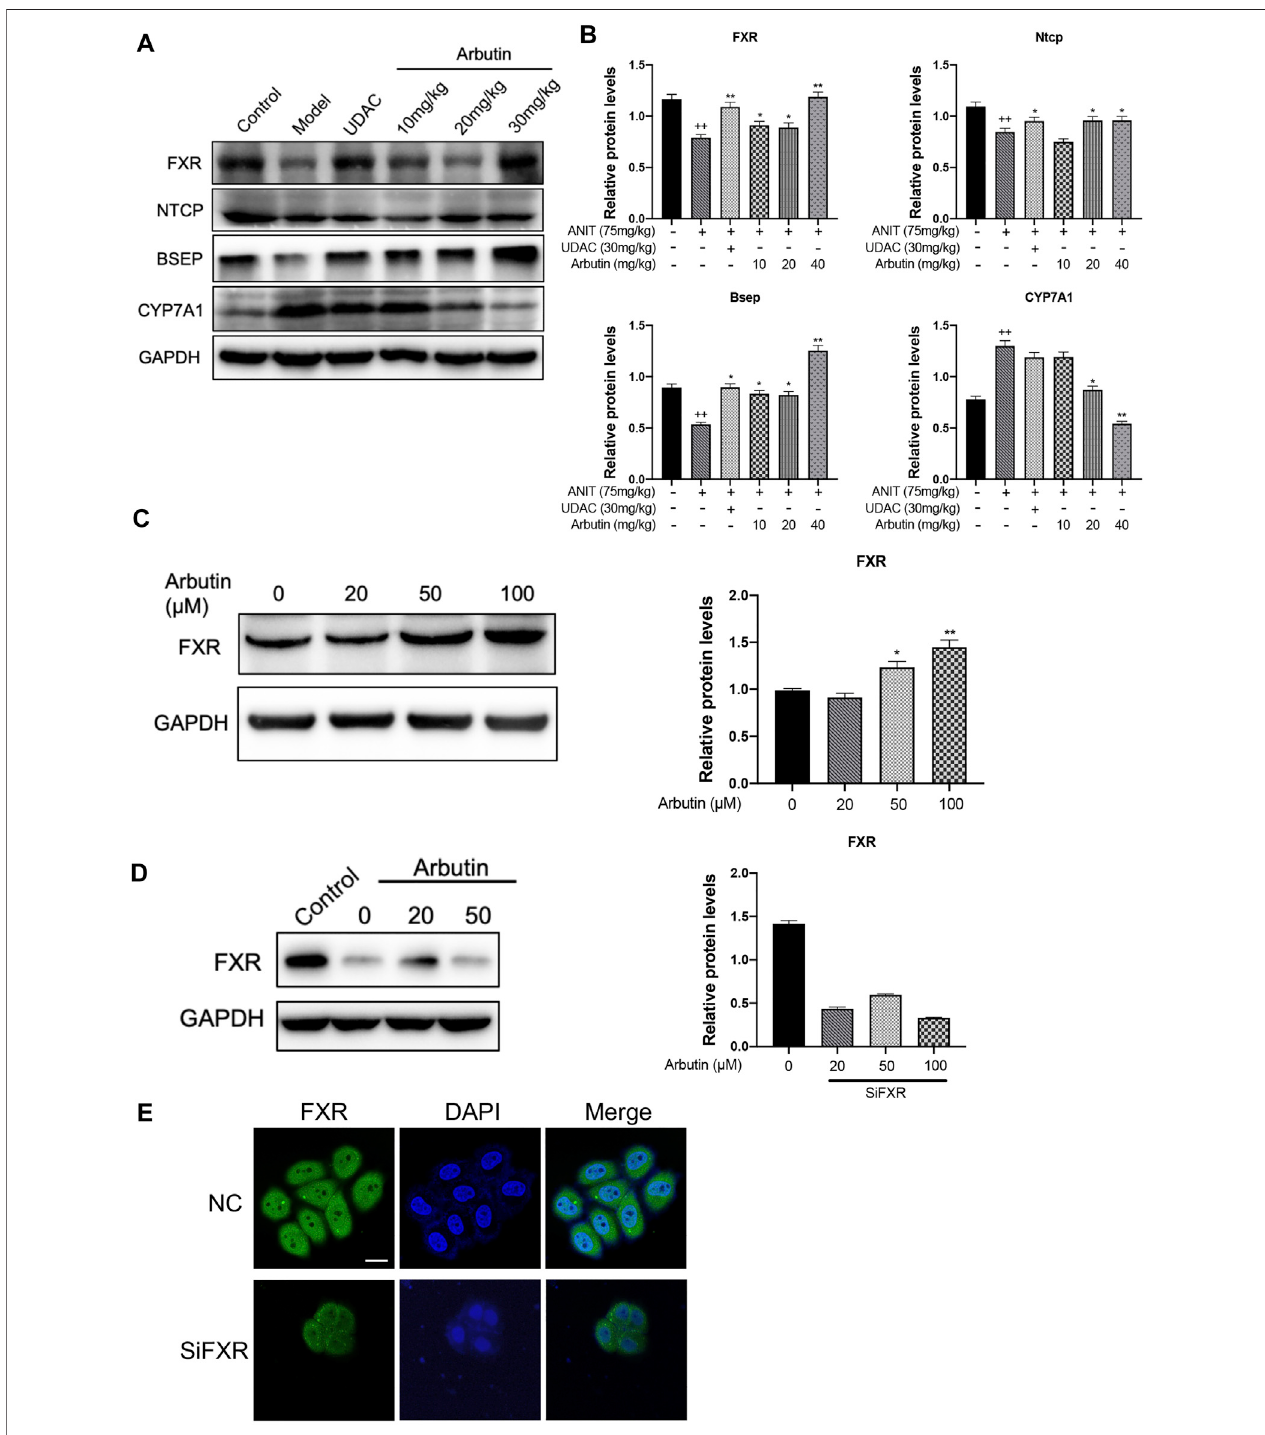
FIGURE 5 | Hepatoprotective effects of arbutin on the FXR signaling pathway in ANIT-induced cholestatic liver disease. (A) WB analysis was applied to shown proteinlevelsofFXR,Ntcp,Bsep,andCYP7A1withtreatment indicated. (B) Theanalysisoftheindicatedproteins. (C) WBanalysiswasusedtoshownthelevelsofFXR in L-02 treated with different concentrates of arbutin. (D) WB analysis effects of arbutin on the expression of the FXR with or without FXR silence. (E) Immunoblotting analysis of FXR protein levels in cells after arbutin was added with or without FXR silence.